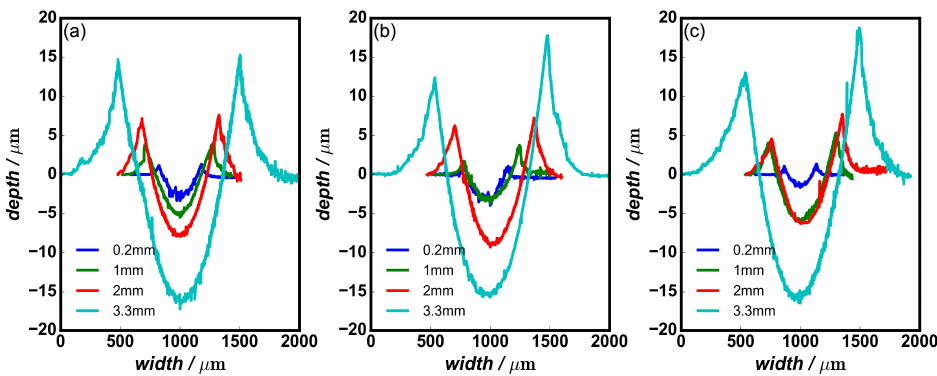
Figure 3. Wear track comparison at various impact heights in three liquids: ( a ) in ethanol; ( b ) in DI water; ( c ) in sea water. The average of three repetitive results was used for each situation. The wear track was moved to the center in order to be easily compared.